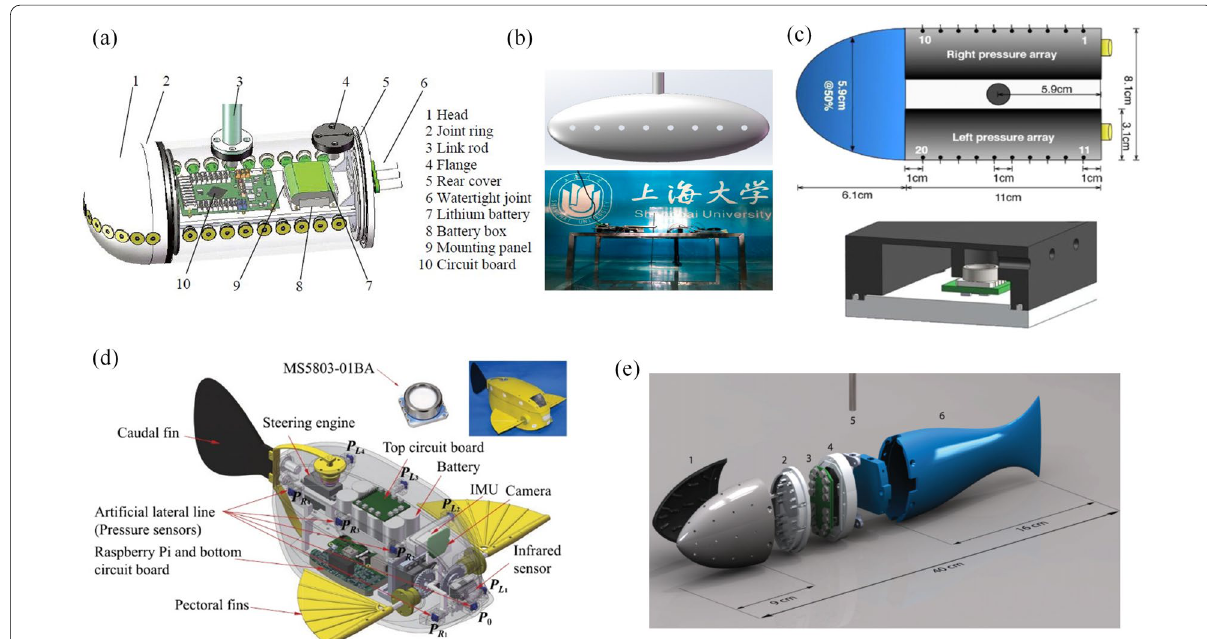
Figure 5 Different artificial LLS systems: ( a ) The carrier model equipped with artificial LLS system [172]; ( b ) The fish-shaped prototype inspired by artificial LLS system [173]; ( c ) Artificial LLS system with rigid body [176]; ( d ) Robotic fish with artificial LLS system [177]; ( e ) A diagram showing the fish-shaped model with artificial LLS system